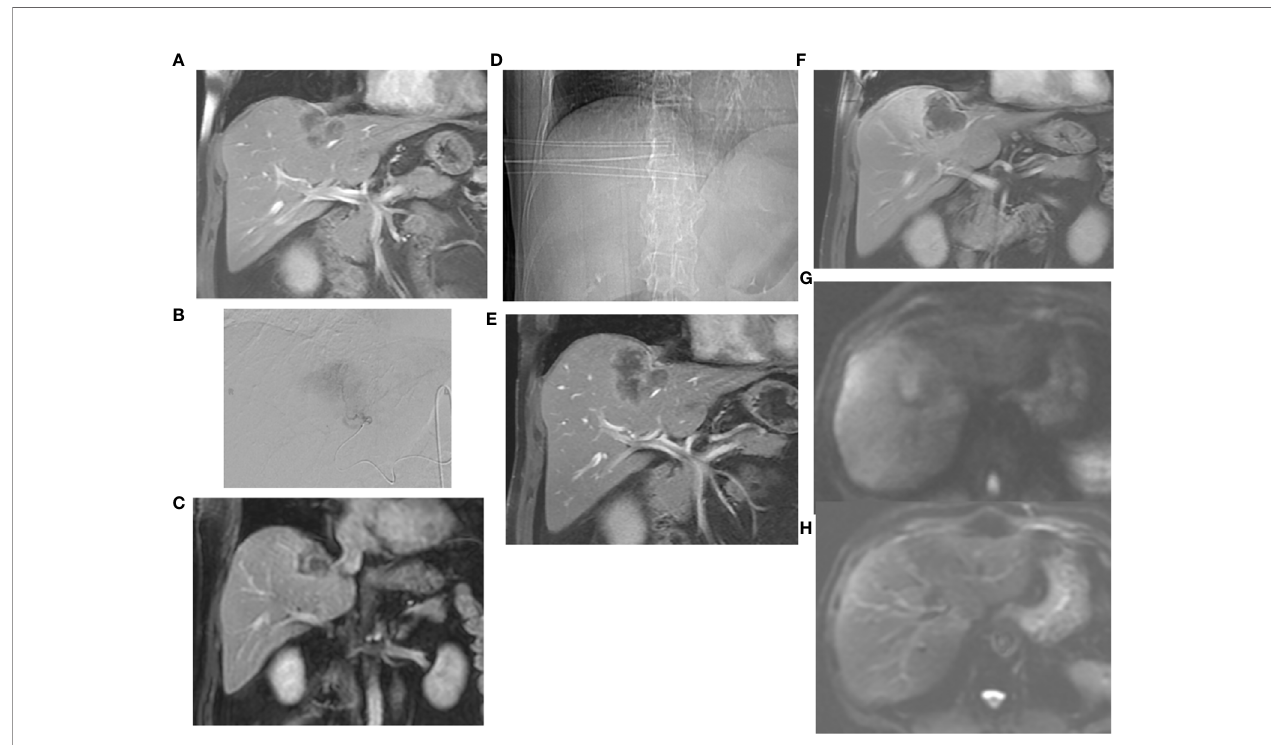
FIGURE 2 | (A) Under third-line systemic chemotherapy, progressive solitary, surgically unresectable colorectal liver metastasis on the border between segment IVa and VIII. (B) The lesion has been initially transarterially chemoembolized with DEB-IRI (Irinotecan-loaded drug-eluting beads). (C) contrast-enhanced MRI shows subtotal devascularisation of the metastasis with a still vital tumour margin on the right lateral-apical side. (D) The marginal recurrences have been interstitially brachytherapied in the interval. The topogram clearly shows the parallel positioning of the applicators. (E) Excellent local tumor control was observed after 3 months. (F) timely shrinkage of the metastasis as well as further local tumor control without detection of recurrence after 6 months. (G) Local tumor control also con fi rmed after 12 months by the absence of diffusion restriction in DWI. (H) The corresponding